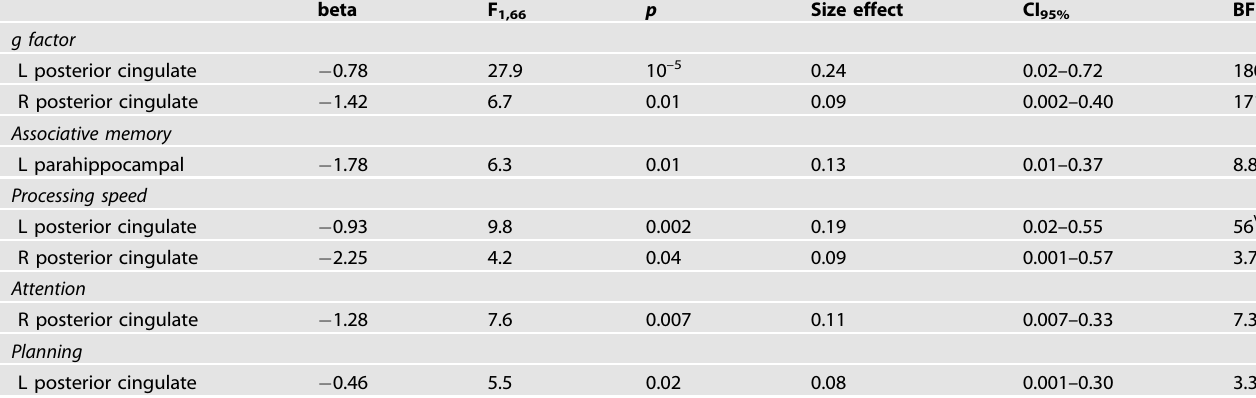
Table 4. Association of cognition with global A β load-induced changes in cortical myelin